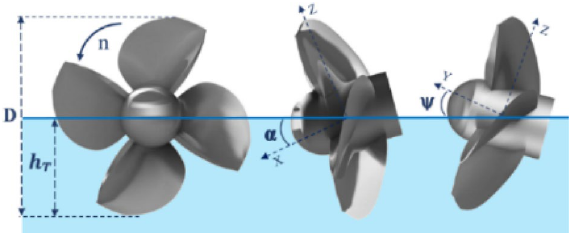
Figure 1. Position parameters of a SPP against free surface (Solidworks 2014, https:// www. solid works.